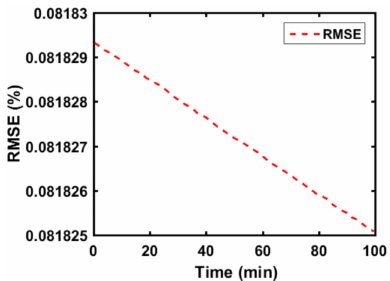
Figure 14. Comparison between Actual and Estimation SOC.